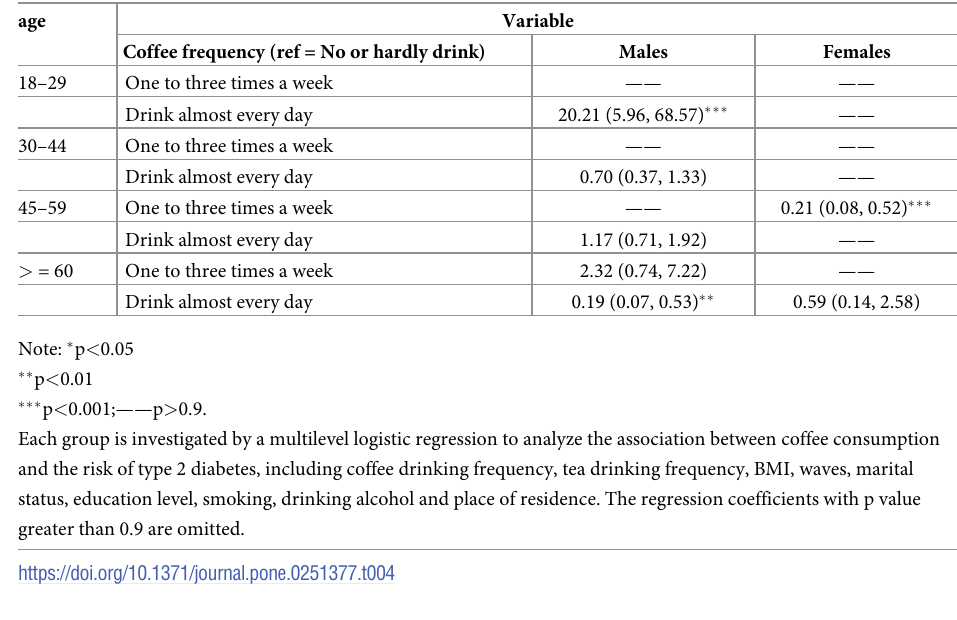
Table 4. Association of coffee consumption with the risk of type 2 diabetes by gender and age subgroup. age